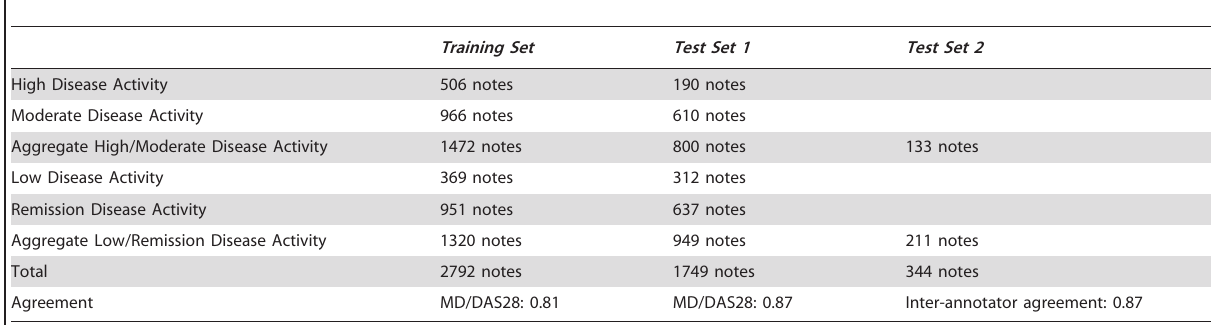
Table 1. Dataset